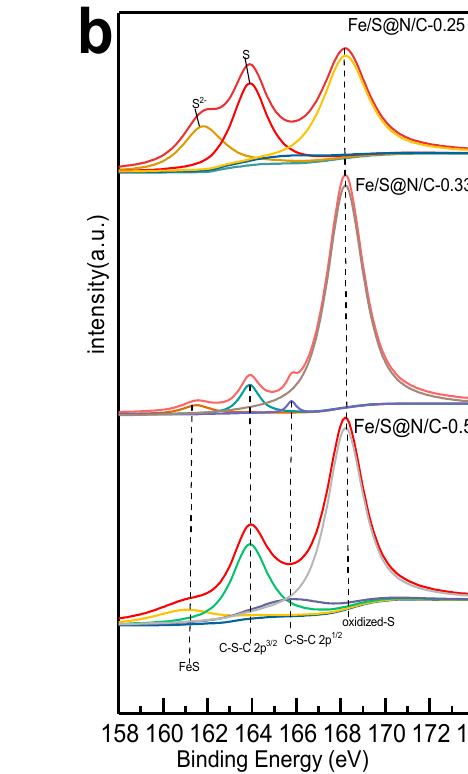
Figure 7. survey XPS spectrum of Fe/S@N/C-x.